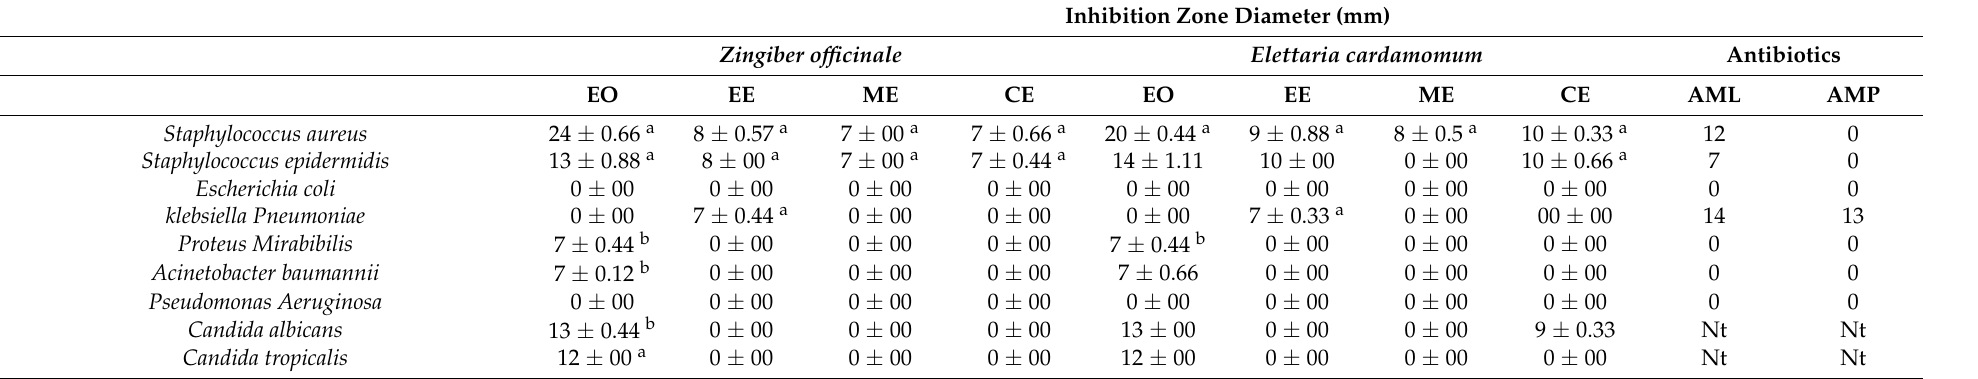
Table 3. Antibacterial activities of Zingiber officinale Roscoe and Elettaria cardamomum (L.) Maton essential oils and extracts. Inhibition Zone Diameter (mm) Zingiber officinale Elettaria